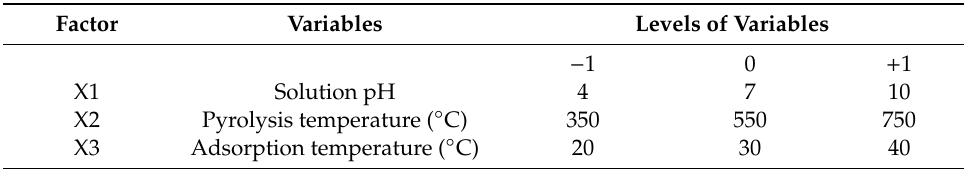
Table 2. Coded and actual values of the various variables (pH, pyrolysis, and adsorption temperature) used in Box–Behnken